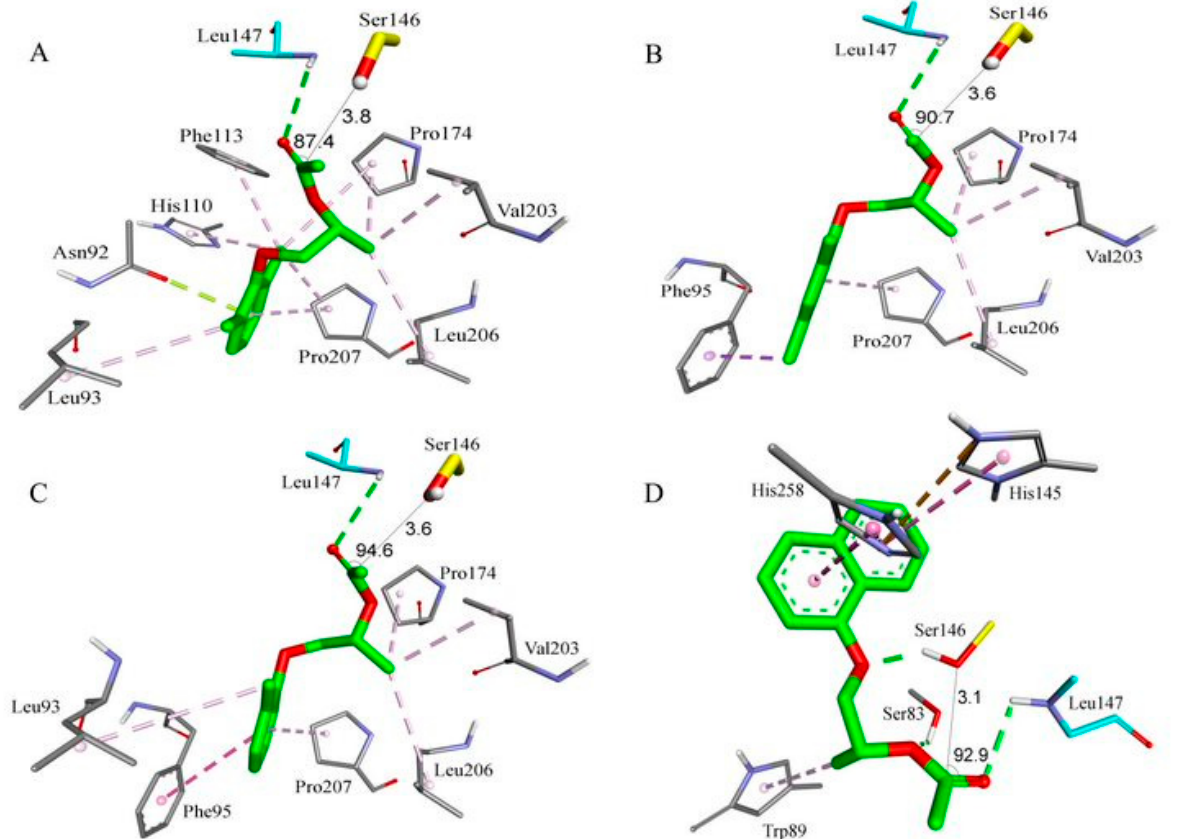
Figure 3. Interactions between TLL and substrate ( R )- 5a - d that follow the criteria established by the NAC. TLL and substrate ( R )- 5a ( A ); TLL and substrate ( R )- 5b ( B ); TLL and substrate ( R )- 5c ( C ) and TLL and substrate ( R )- 5d ( D ). Green dotted lines indicate hydrogen bonds with the oxyanion hole.